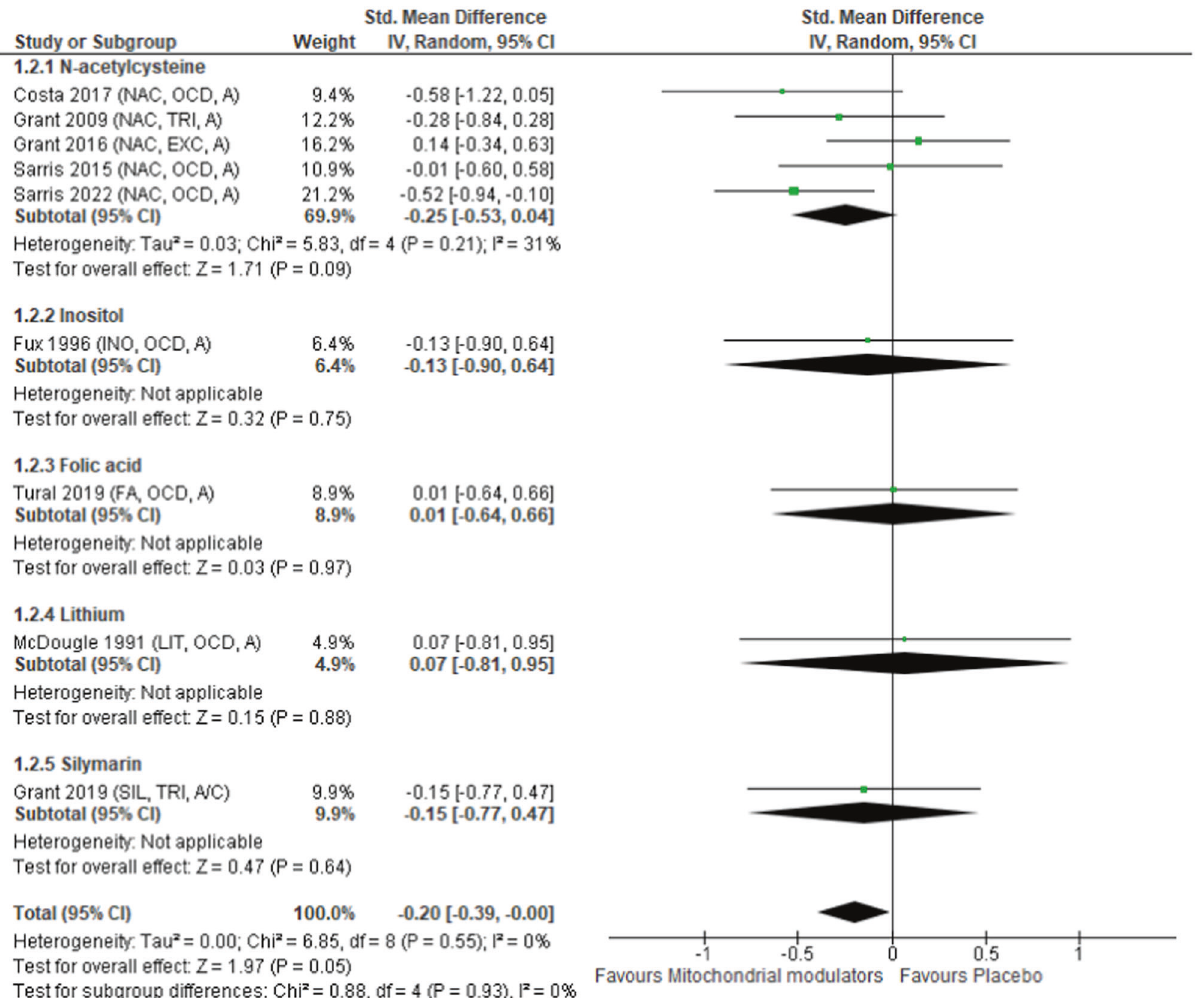
Fig. 2 Forest plot for anxiety symptoms. Studies are listed by names of the fi rst authors and year of publication, with abbreviations for drugs listed in parentheses ( A , B , C ). A Listing by mitochondrial modulator name. FA folic acid, INO inositol, LIT lithium, NAC N-acetylcysteine, SIL silymarin. B Listing by diagnosis. EXC excoriation disorder, OCD obsessive – compulsive disorder, TRI trichotillomania. C Listing according to adults ( A ) or children ( C ).